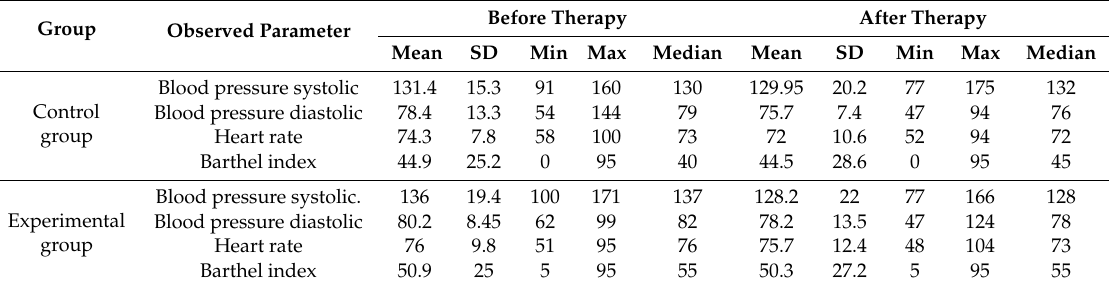
Table 1. Descriptive statistics before and after animal-assisted therapy.